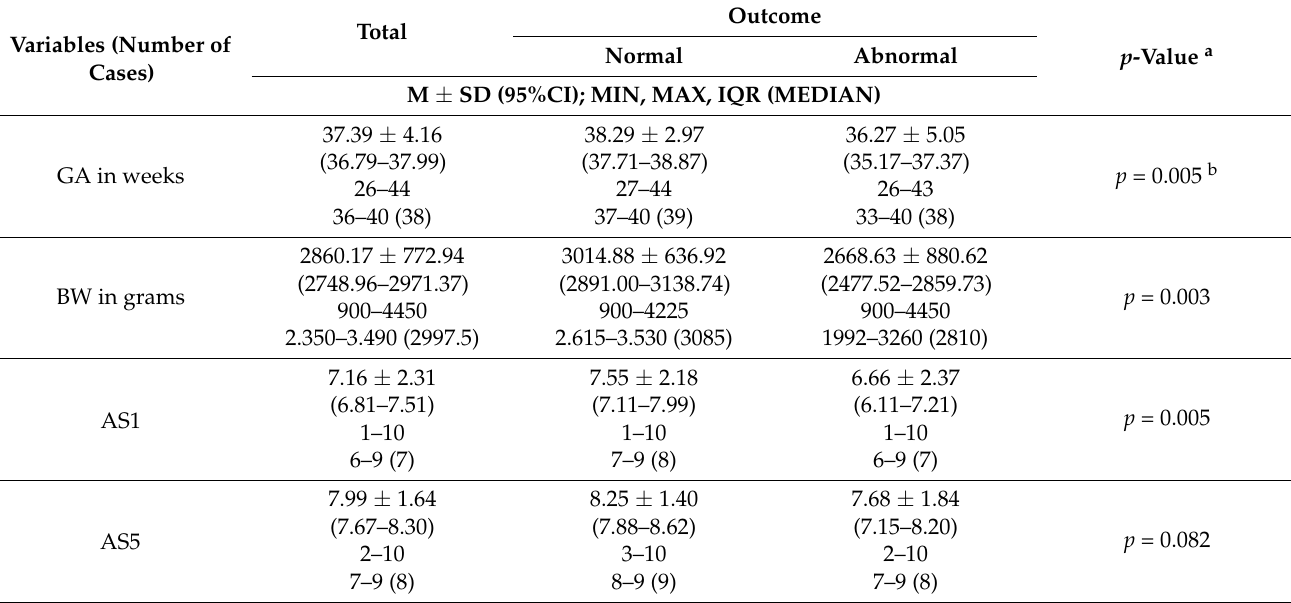
Table 2. Descriptive statistics for GA, BW, AS1, AS5 variables in both normal and abnormal outcomes for the study group.